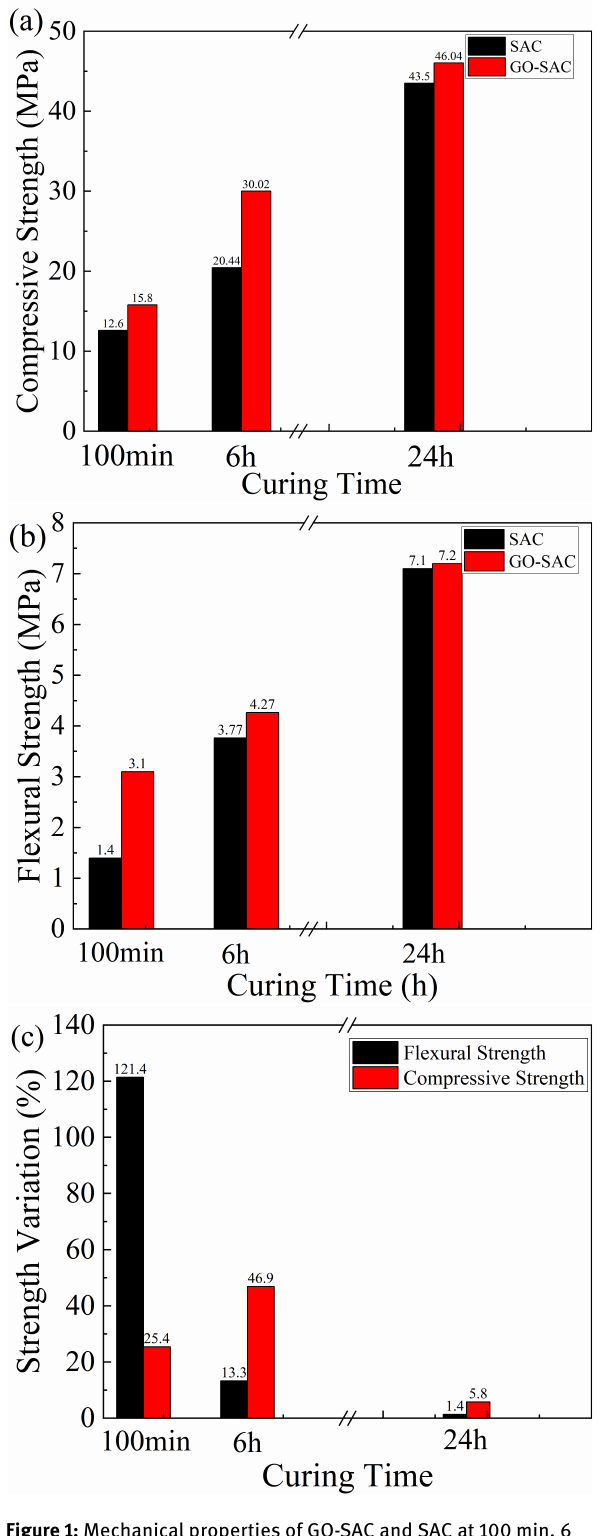
Figure 1: Mechanical properties of GO-SAC and SAC at 100 min, 6 h and 24 h. (a) the compressive strength; (b) flexural strength of samples; (c) the strength variation of samples at different